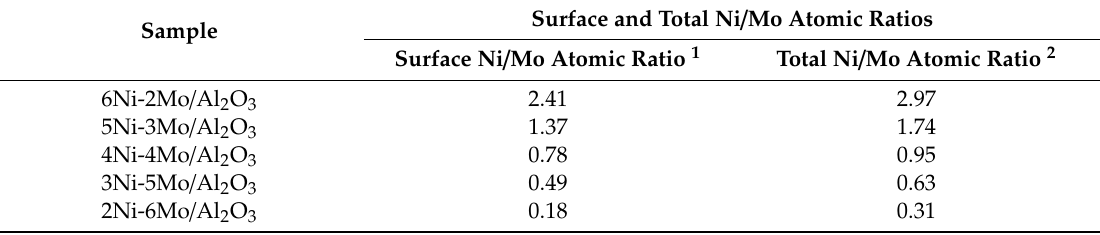
Table 2. The surface and total Ni / Mo atomic ratios of the Ni-Mo sulfide / Al 2 O 3 catalysts with di ff erent Ni / Mo molar ratios.